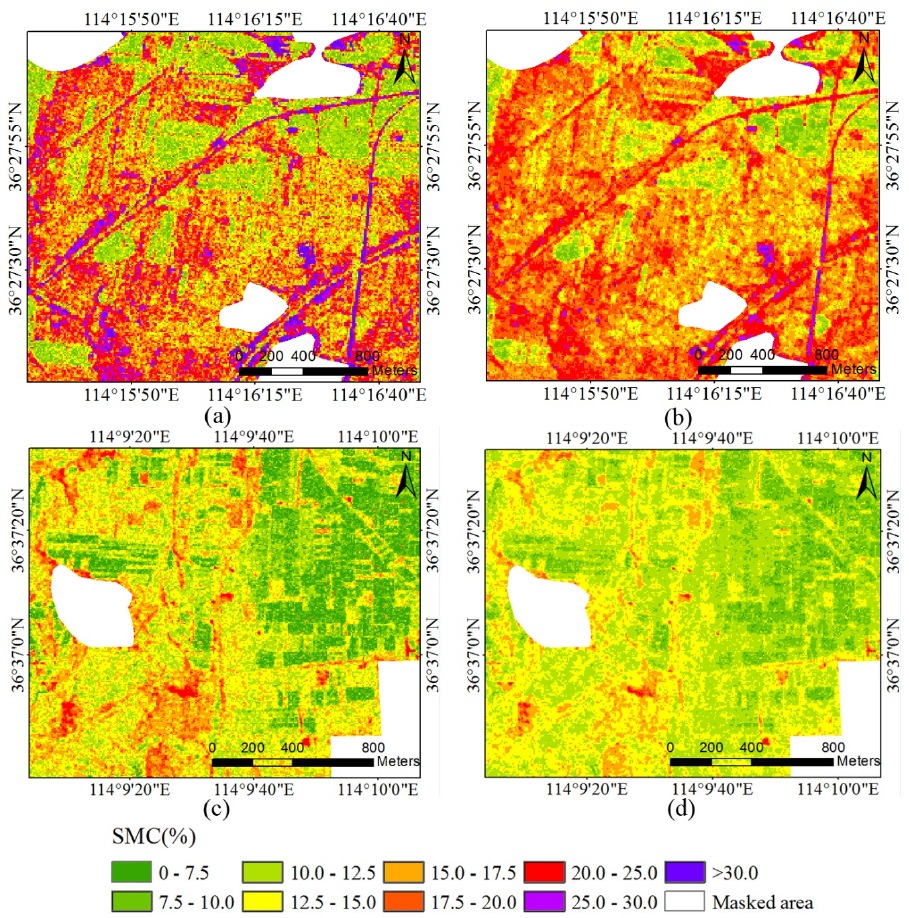
Figure 4. Soil moisture content maps of the Jiulong and Wannian experimental areas produced by the SVR model and modified Dubois model based on TerraSAR-X and Radarsat-2 data: ( a ) Jiulong experimental area with SVR model; ( b ) Jiulong experimental area with modified Dubois model; ( c ) Wannian experimental area with SVR model; and ( d ) Wannian experimental area with modified Dubois model. Rural areas are masked in white.